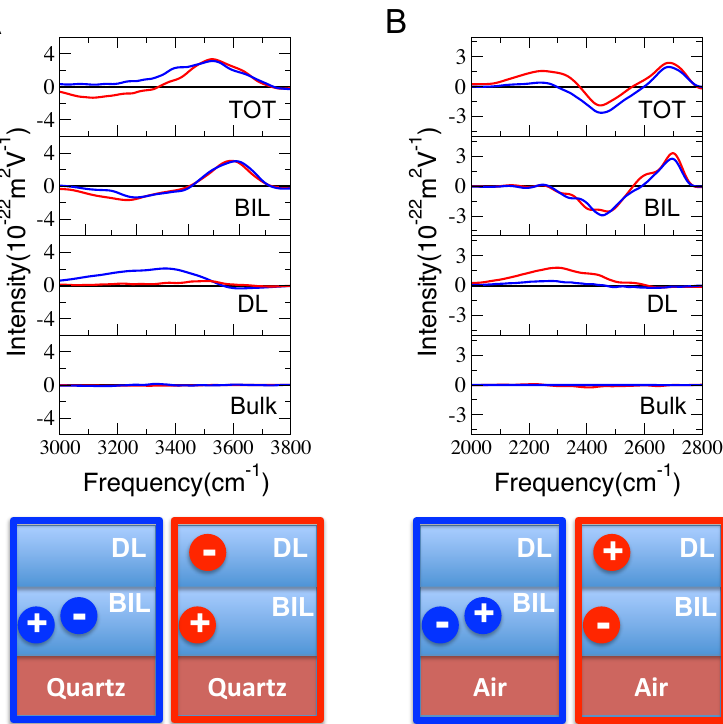
Figure 3. ( A ) Calculated Im χ ( 2 ) ( ω ) spectra for a KCl electrolytic (0001) α -quartz interface (1 KCl vs. 518 water molecules in the simulation box), where the surface oxide is dehydroxylated by 3% (denoted “3% dep” in the text and figures). Two possible ionic arrangements were considered: either both ions are simultaneously located in the BIL (in blue), or K + located in the BIL while Cl − is in the DL (in red). ( B ) Calculated Im χ ( 2 ) ( ω ) spectra for a KCl electrolytic air–water interface (here D 2 O, 1 KCl vs. 256 water molecules in the simulation box). The two possible ionic arrangements are either both ions located simultaneously in the BIL (in blue), or Cl − is in the BIL while K + is in the DL (in red). For ( A , B ), ( 2 ) ( ω ) spectra the total Im χ ( 2 ) ( ω ) spectra (TOT) of the interfaces are presented at the top, the Im χ BIL ( 2 ) ( ω ) spectra of the BIL water layer are of the BIL water layer are presented in the middle, the Im χ DL ( 2 ) ( ω ) spectra of the bulk liquid water (the rest of the water layers at presented below, and the Im χ Bulk the interfaces) are presented at the bottom. Schematic representations of the ion positions in BIL/DL for the four configurations are also presented. The colors surrounding the schemes (blue/red) refer to the color coding of two ions located simultaneously in the BIL (blue, no-Electric Double Layer (EDL)) and two ions dispatched inbetween the BIL and DL (red,